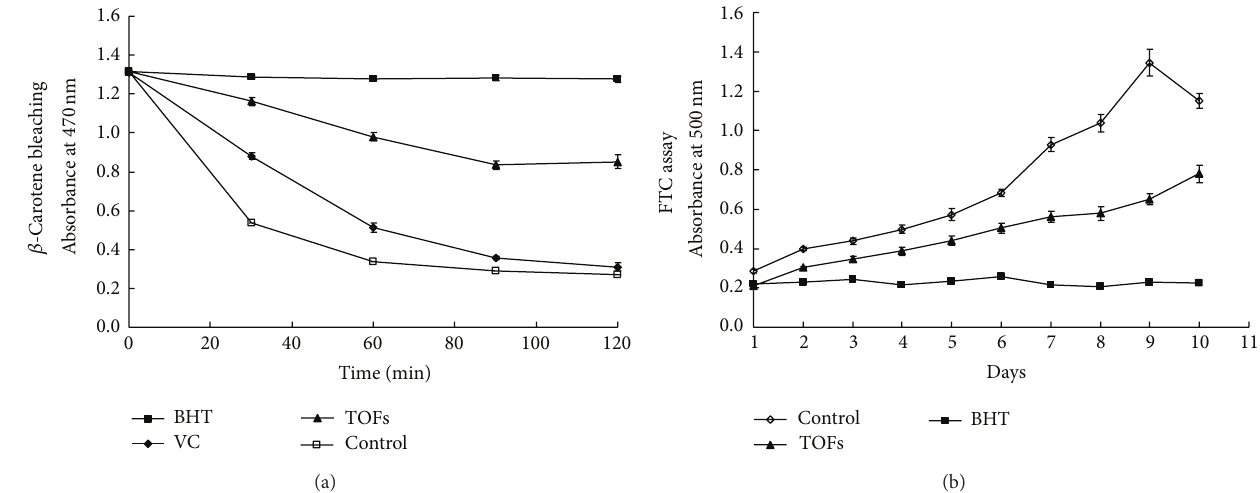
Figure 3: Antioxidant activity determined using 𝛽 -carotene bleaching and